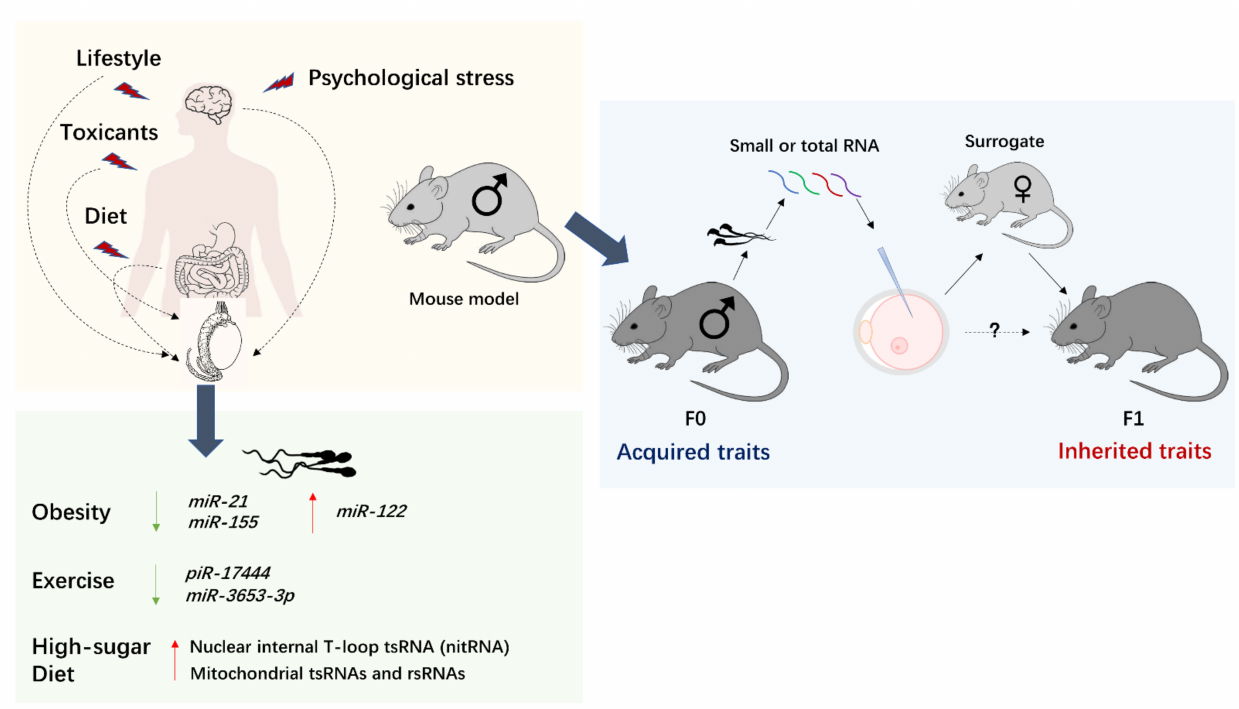
Figure 2. Environmental factors, including psychological trauma, diet, lifestyle choices, and exposure to toxicants, not only affect the exposed individuals but also elicit multigenerational effects. These environmental exposures induce alterations in the sperm sncRNA profile of humans. The roles of sperm sncRNA in transmitting acquired traits are mainly investigated in mouse models. Phenotypic changes are induced in those mouse models, mimicking various environmental exposures in humans. Subsequently, total RNA or the small RNA fraction extracted from mature spermatozoa of the phenotypically- changed mouse (F0) is injected into normal zygotes (i.e., generated by unexposed parents). Those RNA-injected zygotes are implanted in unexposed surrogates for further development. The resulting pups or adult mice (F1) are evaluated for